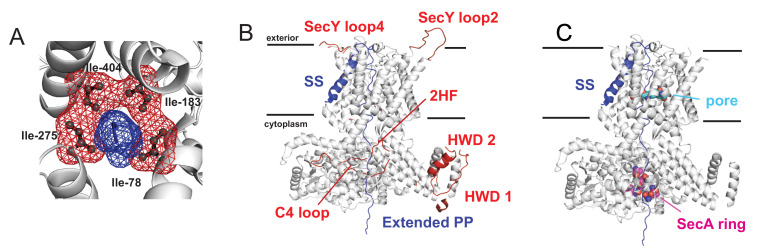
Details on remodelling of the SecA-SecYE-PP complex.(A) Showing how the pre-protein sits in the pore in the original crystal coordinates (Li et al., 2016), with SecY shown as white cartoon, the four pore ring residues (Ile-78, Ile-183, Ile-275 and Ile-404) shown as black sticks and red mesh, and a small section of the pre-protein shown in blue. (B) In white cartoon are the coordinates for SecA and SecYE kept from the original crystal structure (Li et al., 2016). Selected loops which were modelled here are shown as red cartoon and labelled as per Table 1. The modelled pre-protein is shown in blue: the signal sequence and section through SecY are from the crystal coordinates (Li et al., 2016); the section through SecA is labelled ‘Extended PP’. (C) Showing the known pre-protein interactions sites within SecA and SecYE. The SecY pore is shown as light blue spheres, and some of the key SecA pre-protein crosslinking sites in SecA as purple spheres (Bauer and Rapoport, 2009).